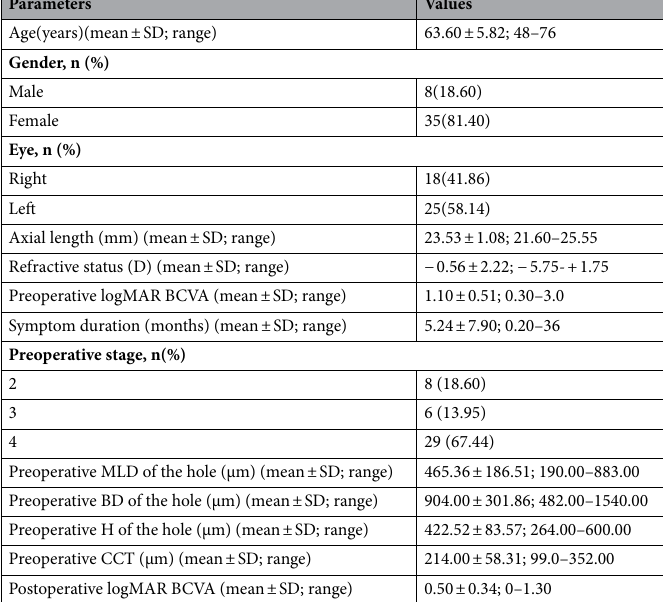
Table 1. Baseline demographic and clinical characteristics of the 43 participants. BD base linear diameter, BCVA best-corrected visual acuity, CCT central choroid thickness, H height (H) of the macular hole, logMAR logarithm of the minimal angle of the resolution scale, MLD minimum linear diameter, SD standard deviation.